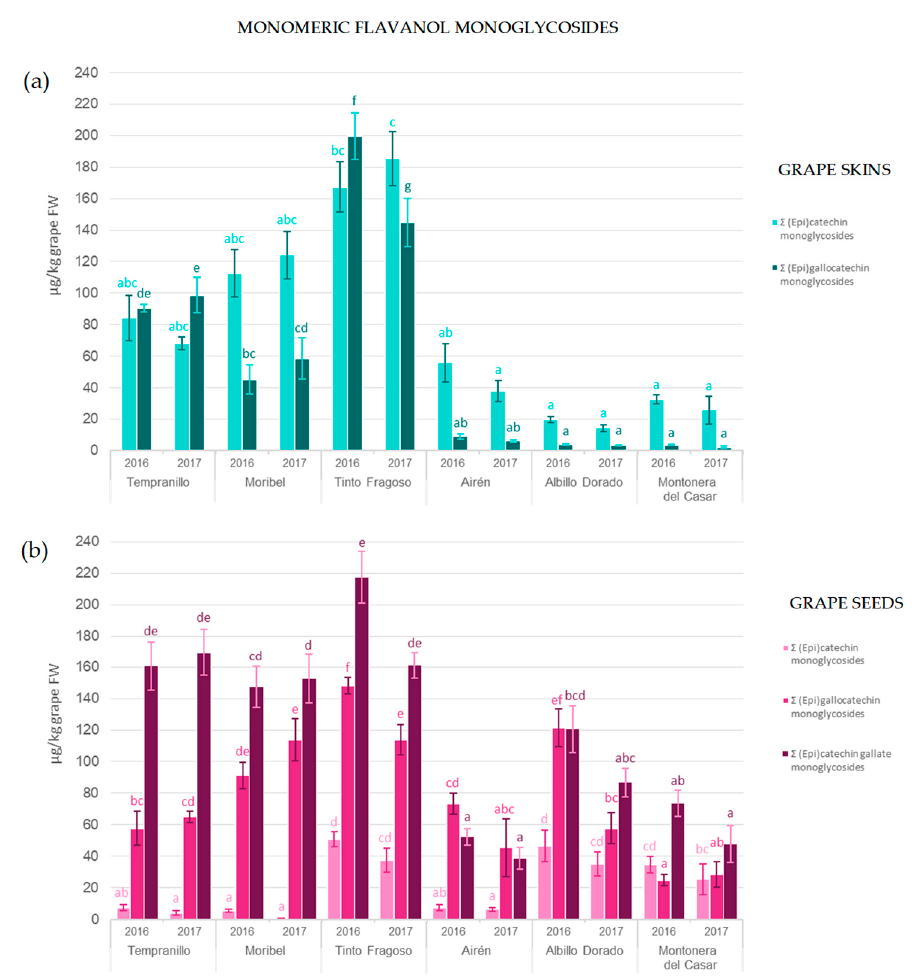
Figure 5. Contents of different monomeric flavanol monoglycosides found in ( a ) skin and ( b ) seed extracts from Vitis vinifera grape varieties.